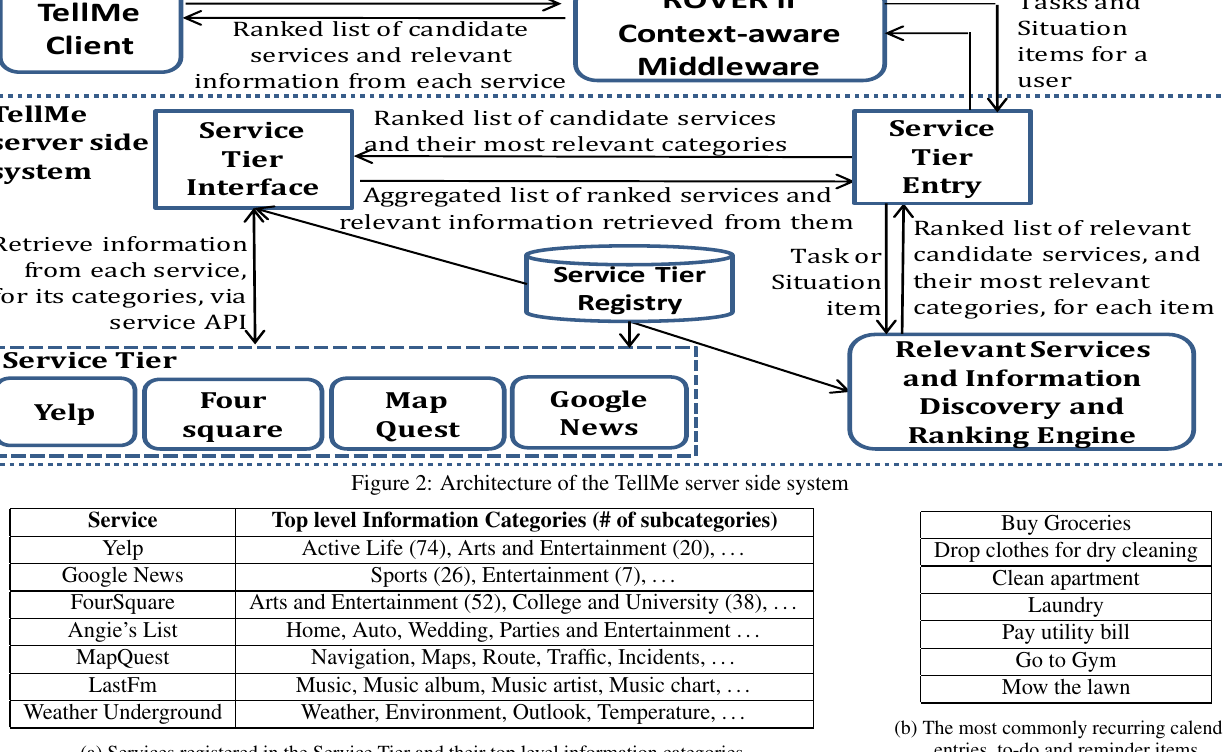
Figure 2: Architecture of the TellMe server side system